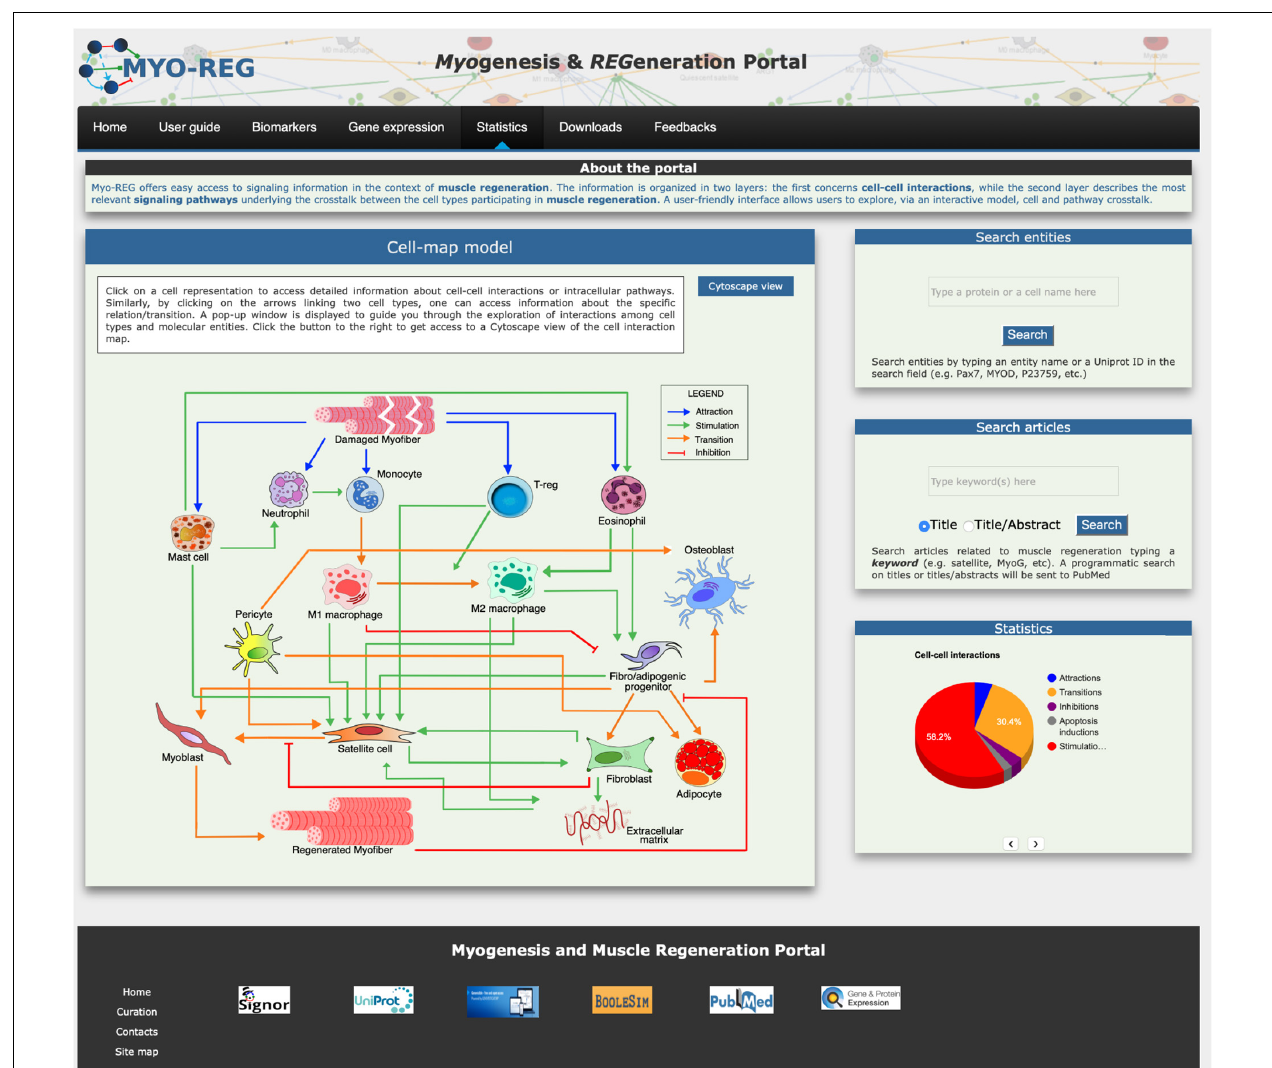
FIGURE 1 | Organization of the Myo-REG home page. Myo-REG allows users to explore several aspects of muscle regeneration. The data types that are annotated in the resource include cell and signaling interactions, cell biomarkers and gene expression data. Blue arrows denote (chemo-) attractions, green arrows denote stimulations, orange arrows are transitions (mostly differentiation processes) and red t-shaped arrows are inhibitions.